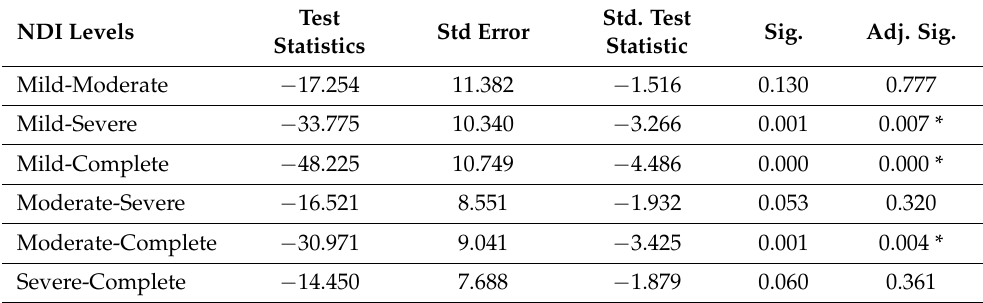
Table 3. The Post-Hoc Test